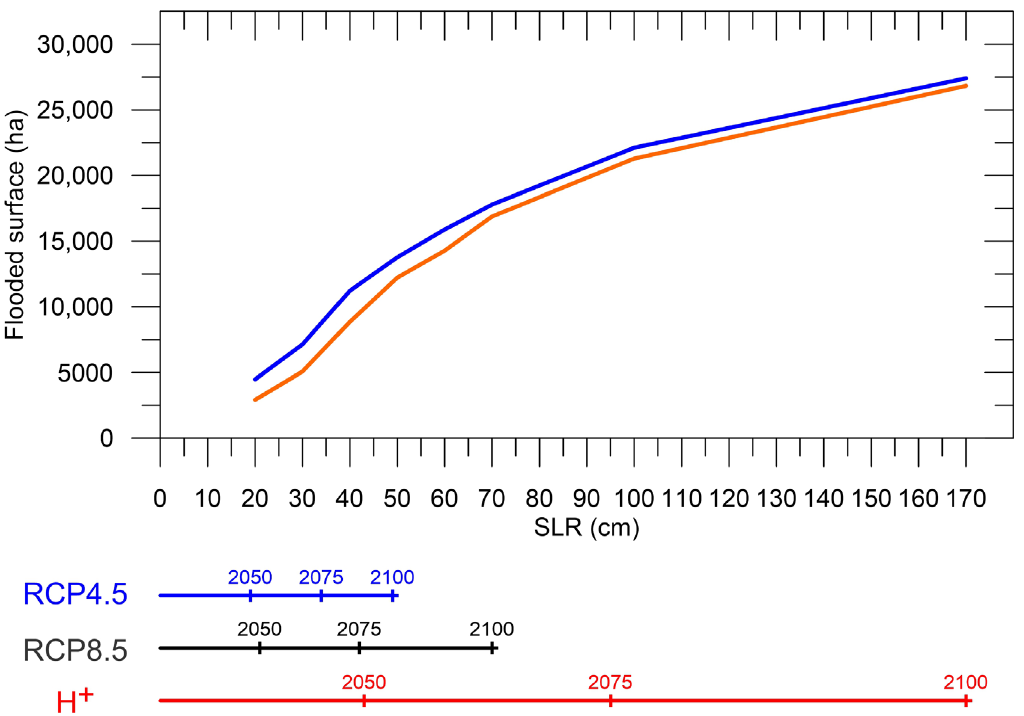
Figure 5. Computed inundated surface (ha) using the classical bathtub approach (blue line) and pseudo-dynamic method (orange line) in the Ebro Delta (ED) under the range of considered relative sea-level rise (RSLR) scenarios. Corresponding timelines for SLR under the selected scenarios are shown at the